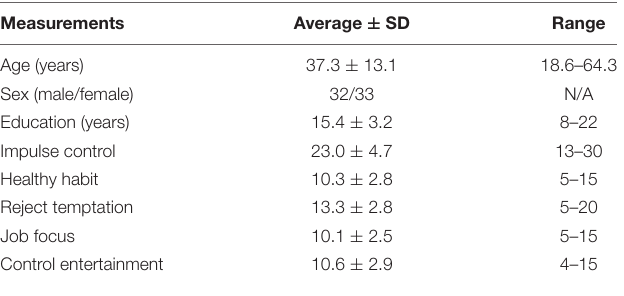
TABLE 1 | Participant